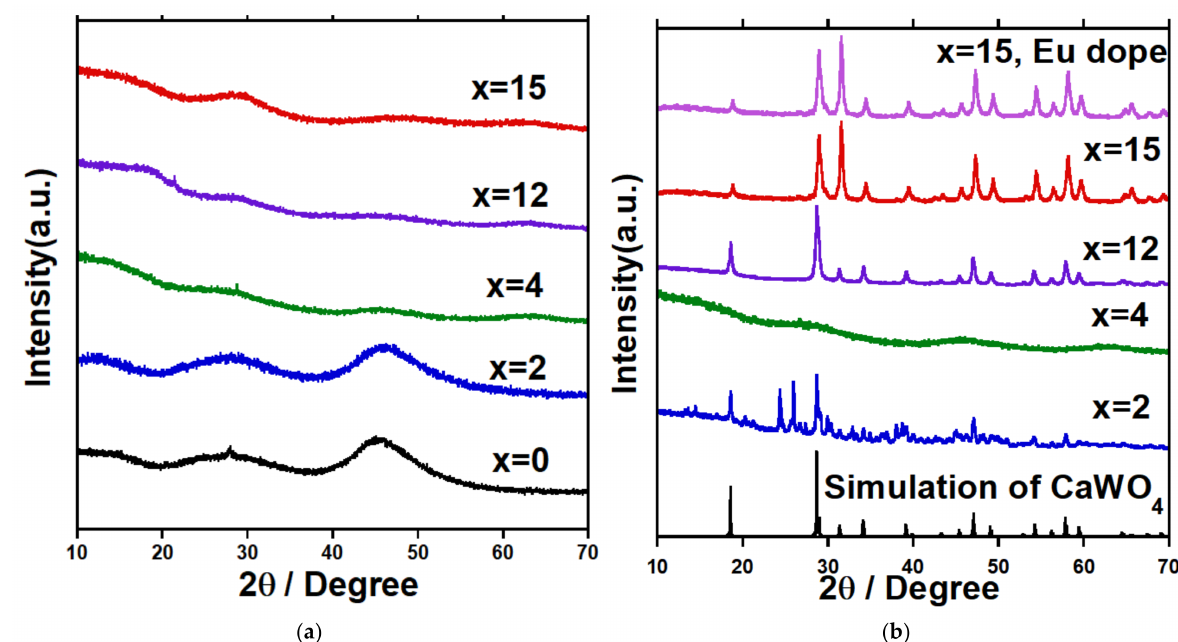
Figure 3. XRD patterns of ( a ) (100 − x ) (33CaO-67B 2 O 3 ) − x Ca 3 WO 6 glass samples and ( b ) (100 − x ) (33CaO-67B 2 O 3 ) − x Ca 3 WO 6 samples after heat-treatment at higher than each T g through to 90